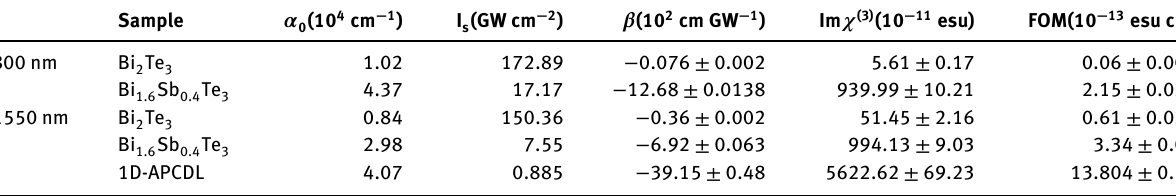
Table 1: Nonlinear performance of materials and 1D-APCDL at 800 nm and 1550 nm.